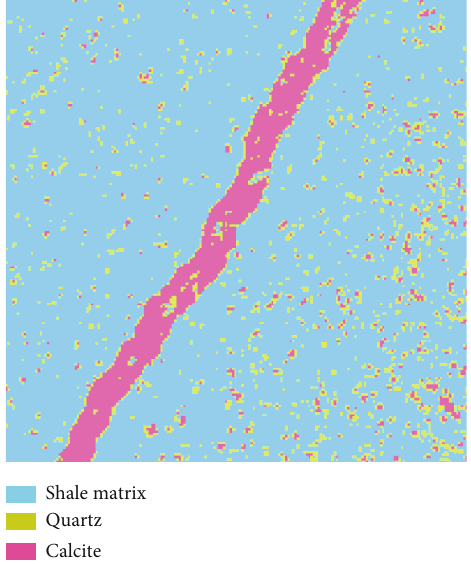
Figure 7: Image after threshold